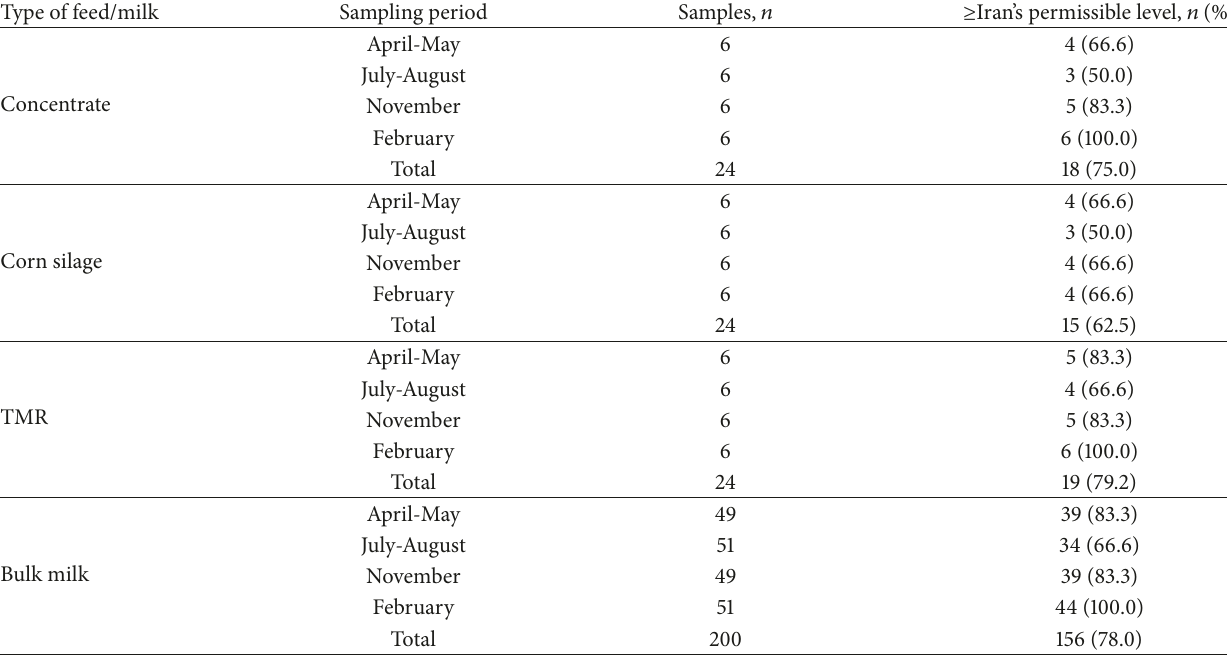
Table 1: Cluster random sampling and widespread contamination of aflatoxin B 1 in feedstuffs and aflatoxin M 1 in bulk milk during spring, summer, autumn, and winter in thestudy area (see also Figure